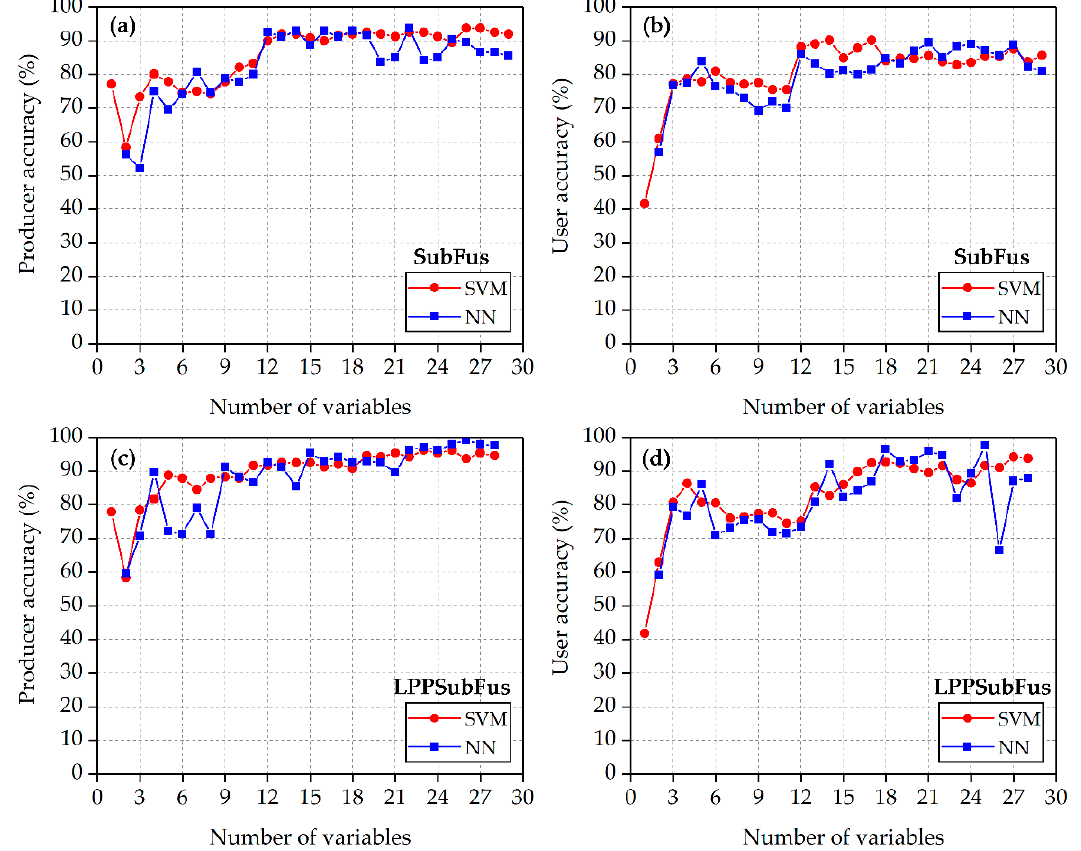
Figure 8. Producer and user accuracy curves of tea plantations varying with the feature number using support vector machine (SVM) and neural network (NN) algorithms: ( a ) producer accuracy using subspace fusion (SubFus), ( b ) user accuracy using SubFus, ( c ) producer accuracy using locality preservation projection and subspace fusion (LPPSubFus), and ( d ) user accuracy using LPPSubFus.